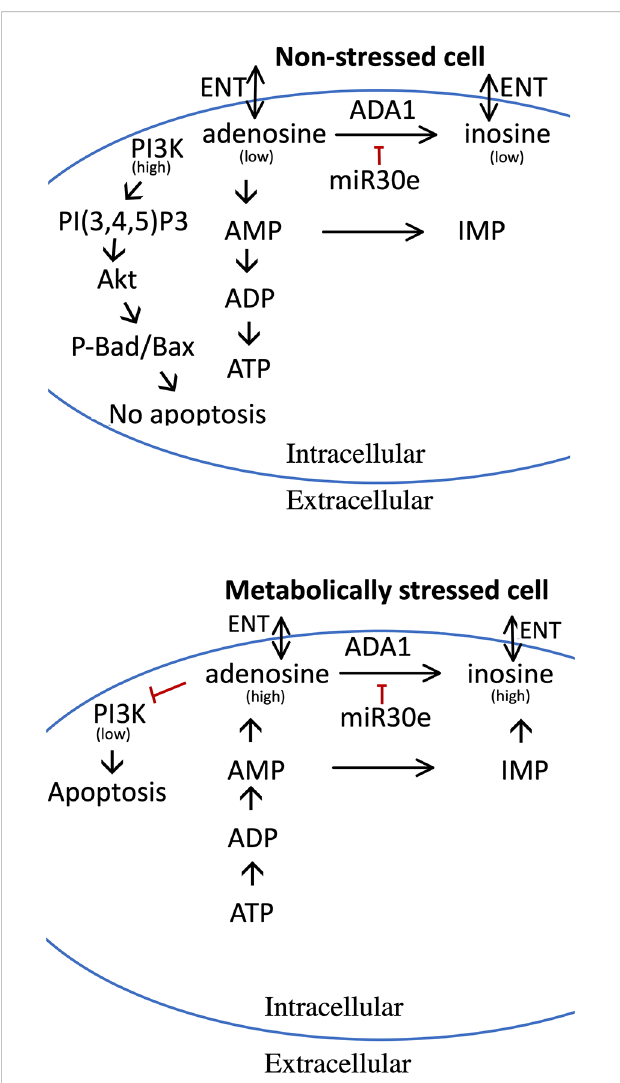
FIGURE 9 Model for the pro-apoptotic role of adenosine and how increased adenosine is metabolized in non-stressed and metabolically stressed beta-cells. Upper panel depicts adenosine metabolism in non-stressed cells, and the lower panel adenosine metabolism and pro-apoptotic effects in stressed cells. In stressed cells, nucleotide dephosphorylation leads to increased adenosine levels, which reduces the activity of the PI3-kinase. In non-stressed cells, adenosine is used for the maintenance of high levels of ADP and ATP, and adenosine levels therefore remain low with little or no effect on the PI3-kinase. High levels of adenosine can be reduced by ADA1 activity, leading to the production of inosine, or by AMP deamination to IMP. ADA1 activity is, however, reduced by miR-30e-3p. Both adenosine and inosine can be release to the exterior of the cell via the ENT transporters. See text for